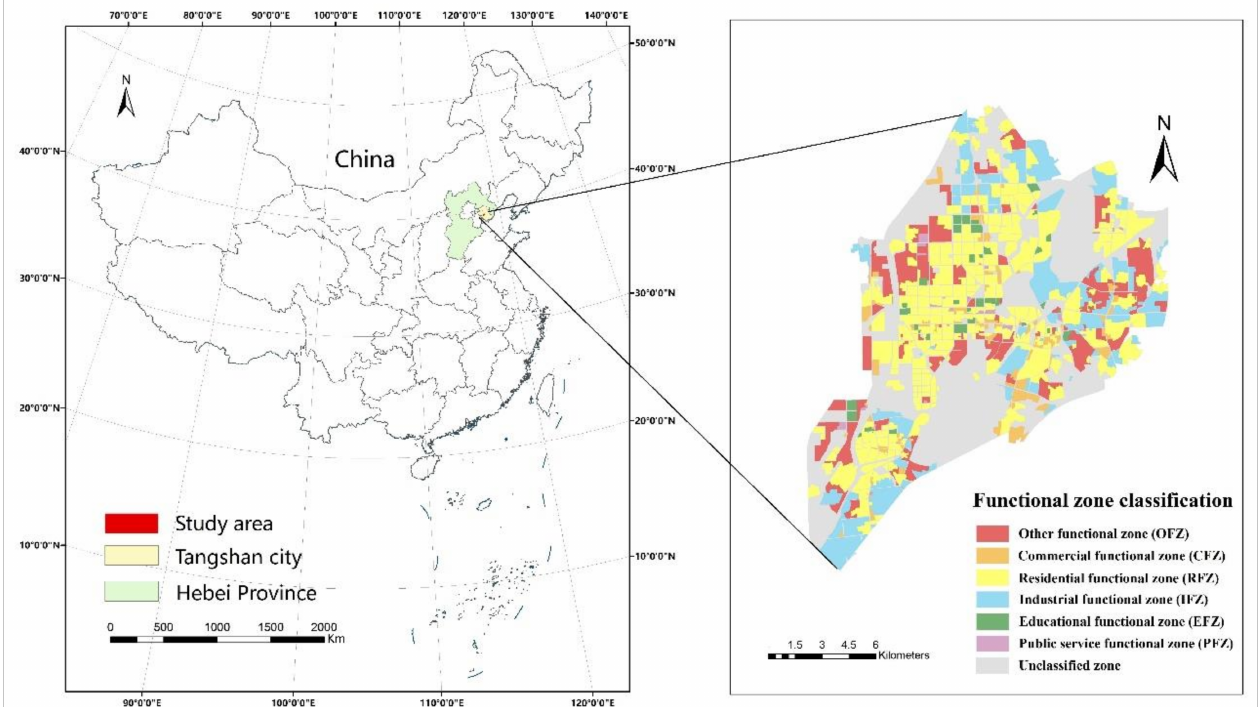
Figure 1. Location of study area and classification of FZs in